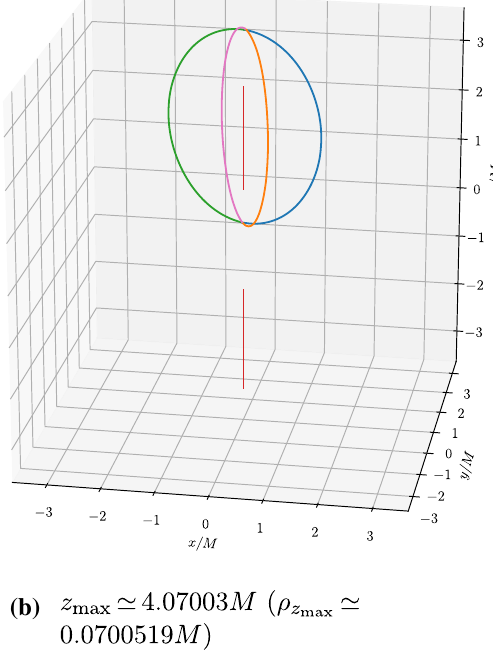
plane for a , and at z min for b . To aid in tracing the path of each orbit, we have divided it into four parts: coloured blue, green, orange and pink, in